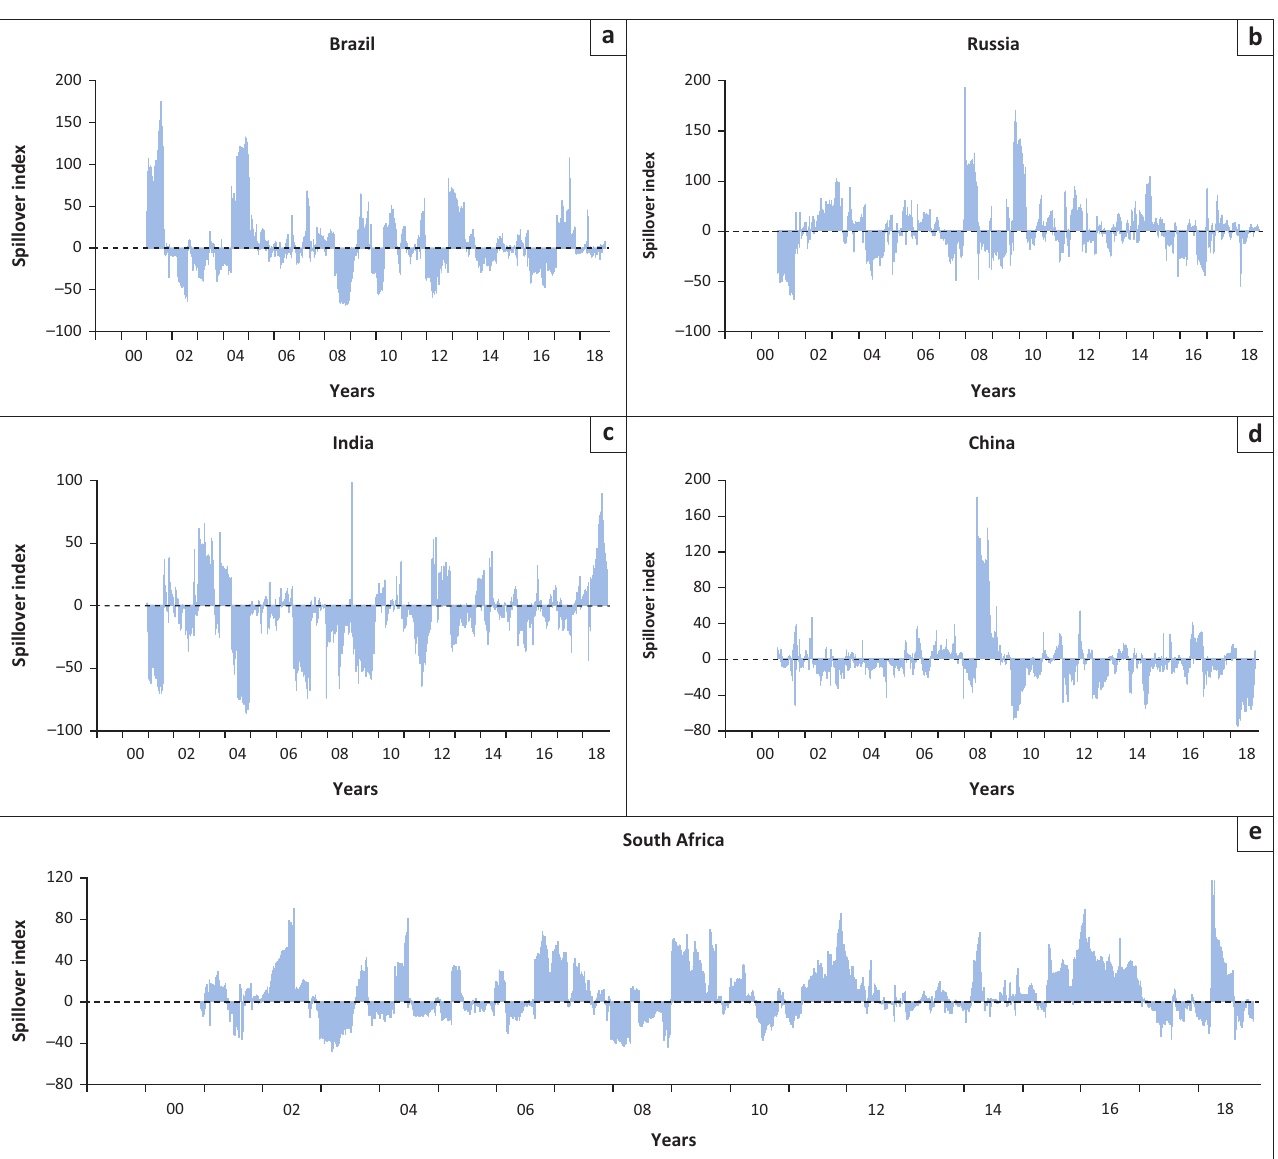
FIGURE 2: Net directional spillovers – Brazil, Russia, India, China and South Africa equity markets